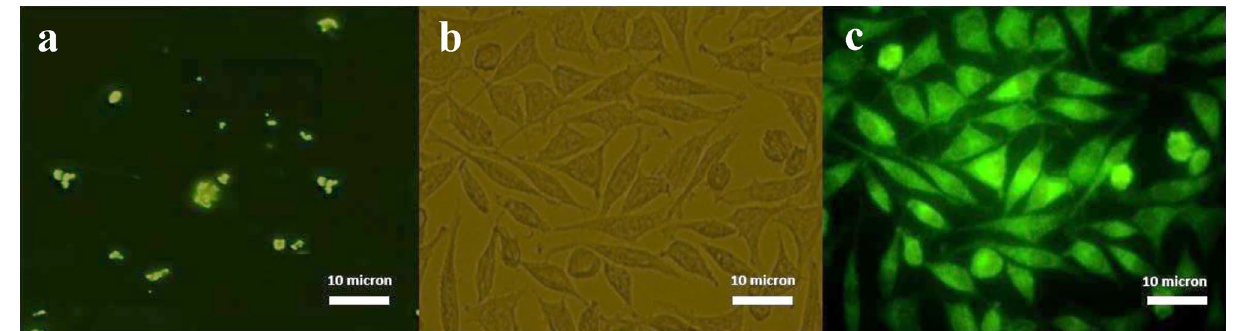
Figure 13. Evaluation of FITC-SPION-Cs-PTX-PEG-FA cell uptake by fluorescence imaging in WEHI-164 cancer cells (×400 magnification). Image of cells treated with PTX with fluorescence microscopy ( a ). FITC- SPION-Cs-PTX-PEG-FA-treated cells using optical microscopy image ( b ). Fluorescence imaging of cells treated with FITC-SPION-Cs-PTX-PEG-FA ( c